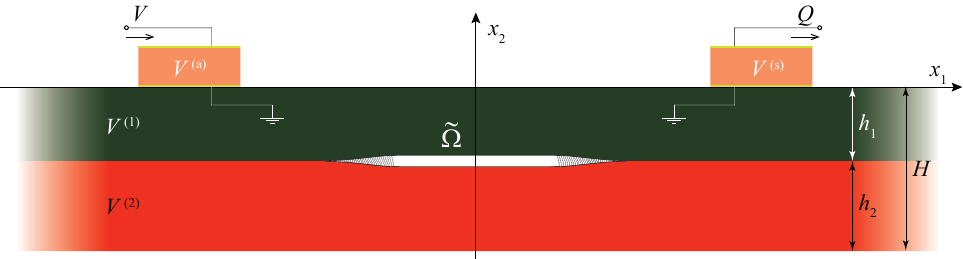
Figure 10. Geometry of the problem: multi-layered waveguide with a distribution of open